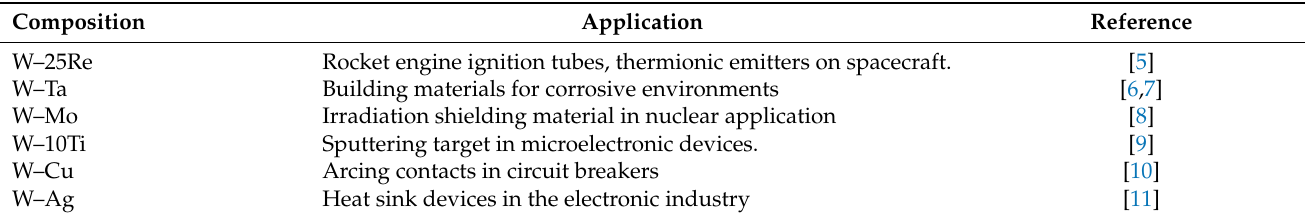
Table 1. Applications of W and its alloys in various